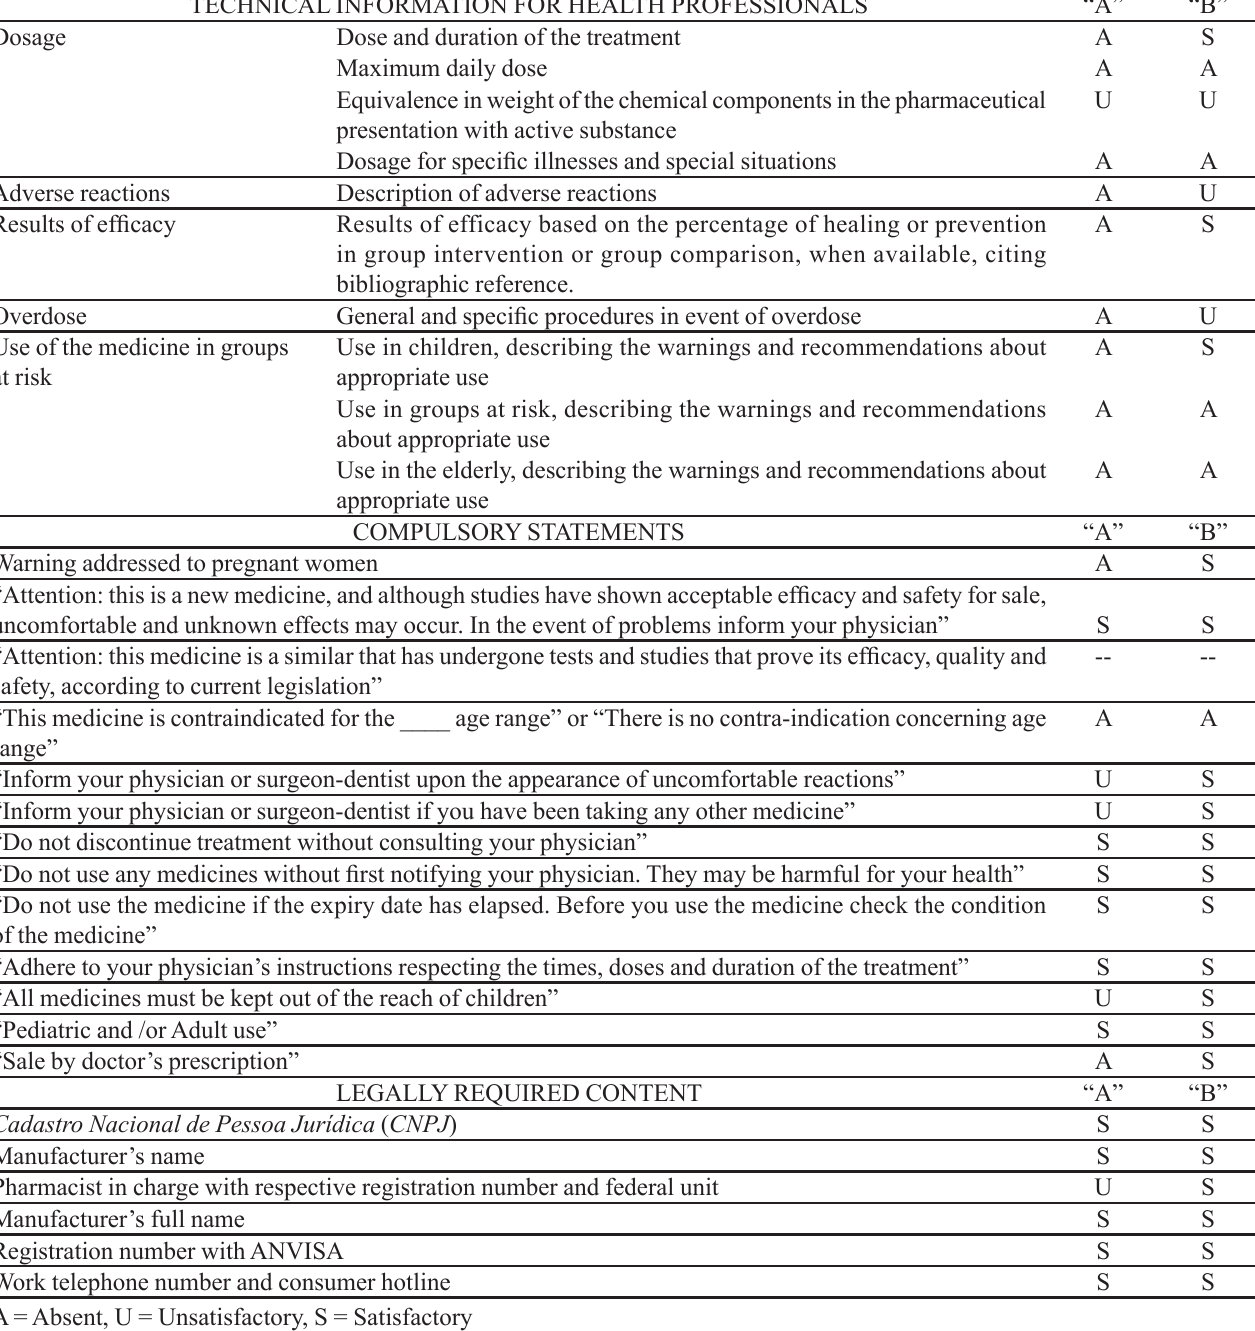
TABLE I – Standard form for evaluation of package inserts according to RDC 140/2003, employed in the verification of package inserts of P. sidoides medicines produced by manufacturers “A” and “B”